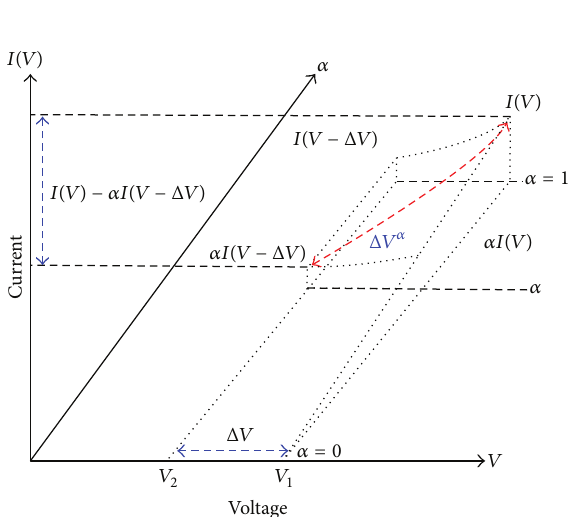
Figure 5: Simulated photovoltaic power system.